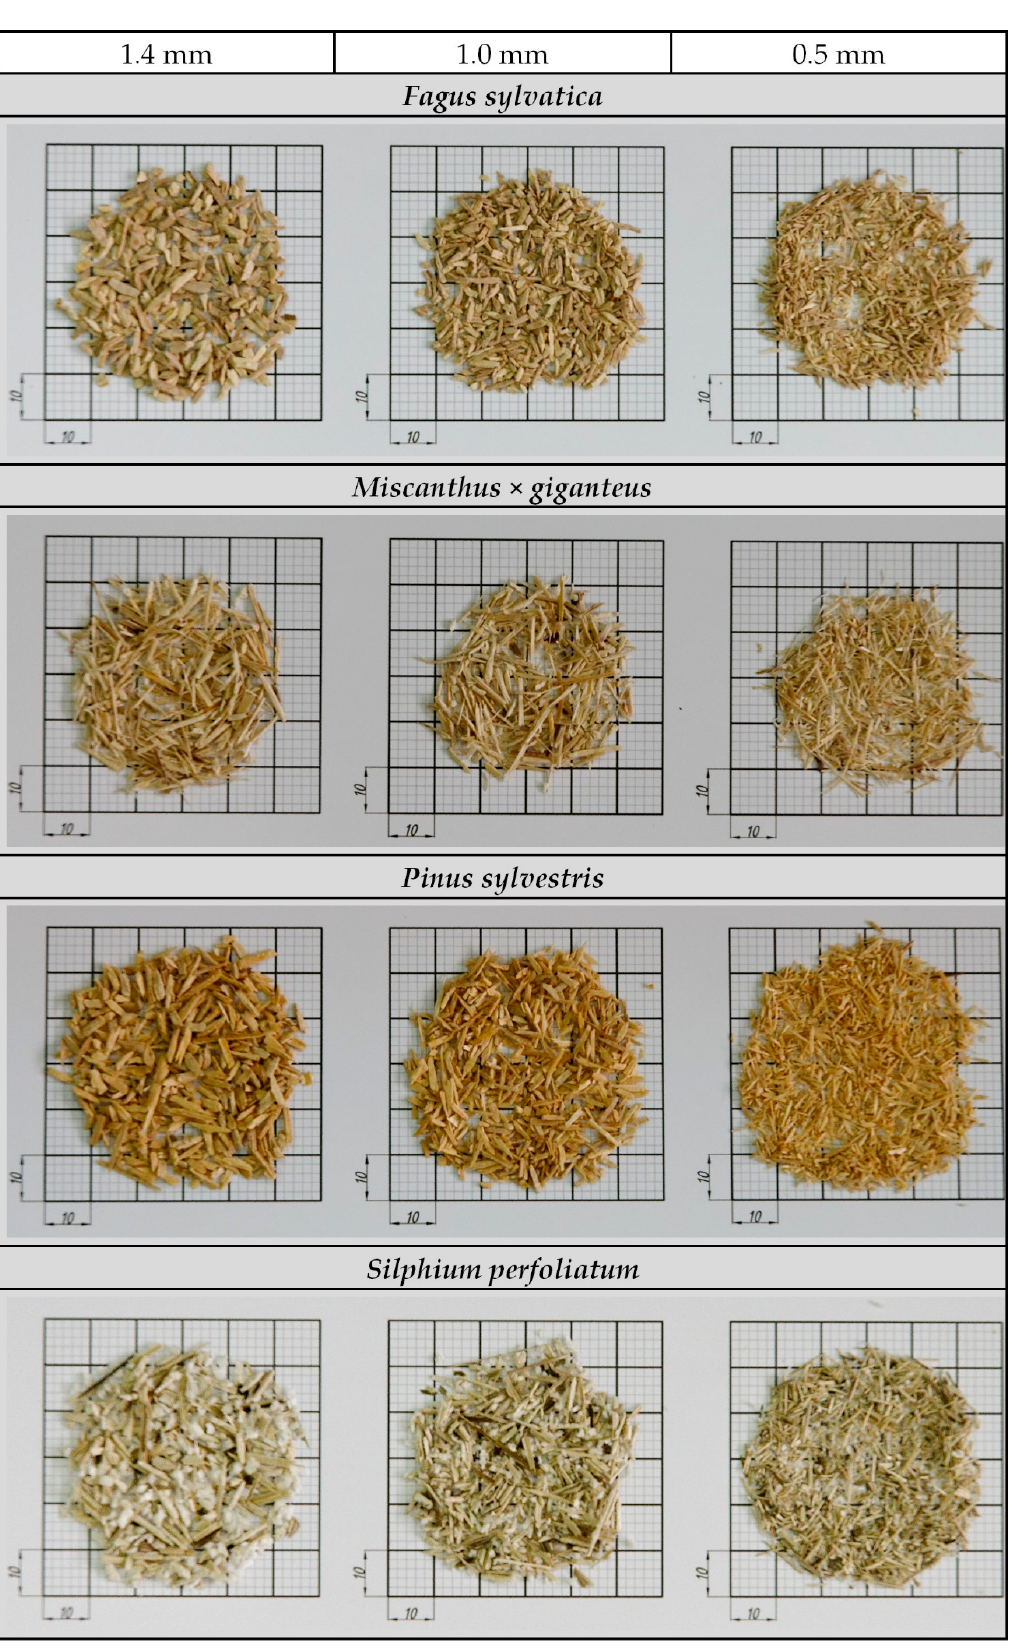
Figure 11. Shapes of the particle of the ground materials.